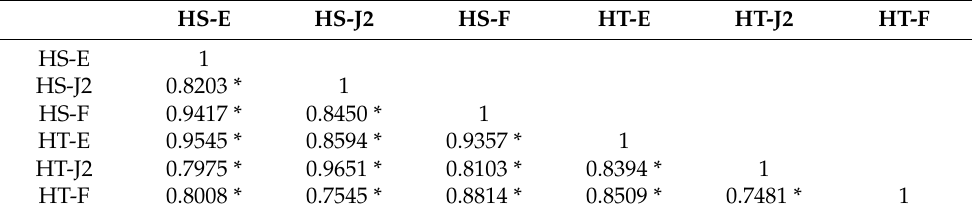
Table 1. Pearson’s correlation analysis of H. schachtii and H. trifolii in the egg, juvenile 2 (J2), and female (F) stages based on the relative peak areas of